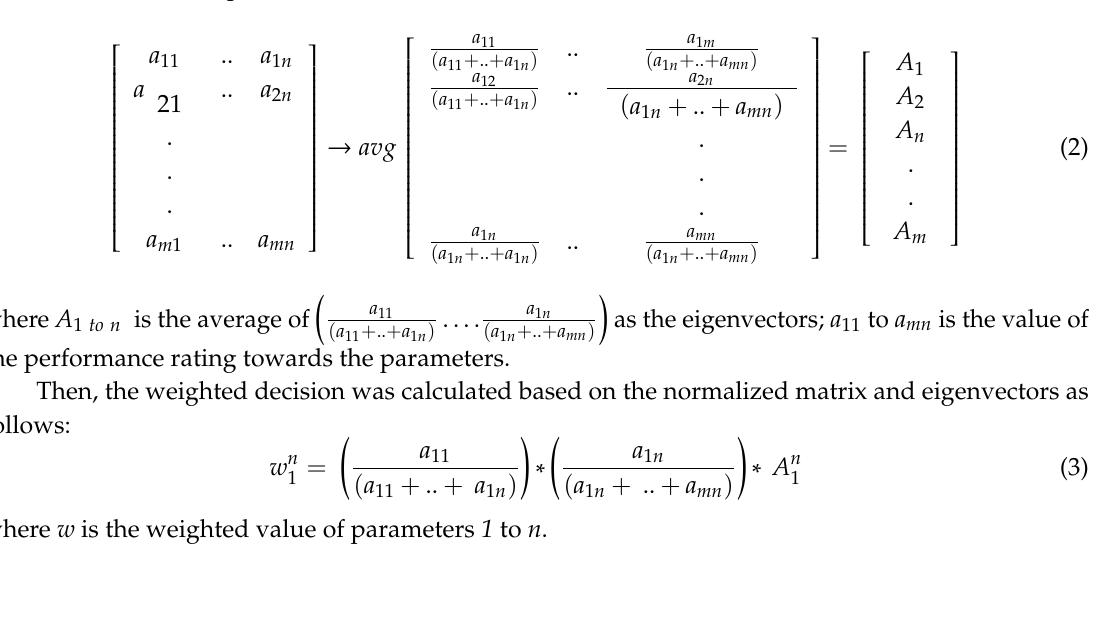
Table 1. Shows the matrix of MCE for coastal flood-prone areas driven by rainfall (CFR)-2 and CFR-3 based on [12]. CFR-2 Classes w CFR-3 Classes Parameter w High S Moderate S Low S High S Moderate S Low S Slope 70 0–2% 3 2–4% 2 > 4% 1 35 0–2% 3 2–4% 2 > 4% 1 Land cover / use 35 Settlements 3 ≥ 200 ≤ 50 50–200 Rainfall 30 mm mm 3 mm